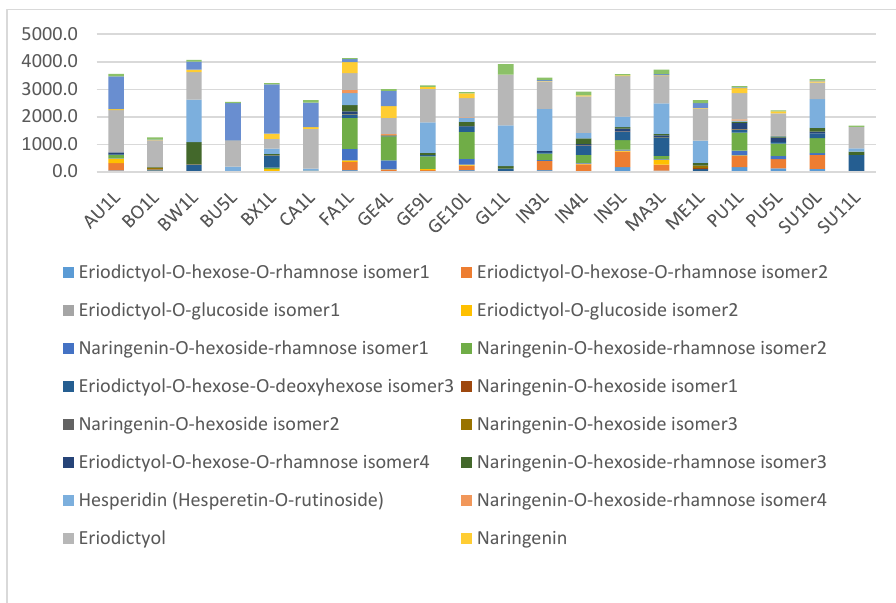
Figure 11. Composition of the flavanones in the leaf (L) samples in the different Cyclopia species in mg/kg relative to mangiferin. For sample codes see Table 2). C. aurescens (AU), C. bolusii (BO), C. bowiena (BW), C. burtonii (BU), C. buxifolia (BX), C. capensis (CA), C. falcata (FA), C. genistoides (GE), C. glabra (GL), C. intermedia (IN), C. maculata (MA), C. meyeriana (ME), C. plicata (PL), C. pubescens (PU) and C. subternata (SU).